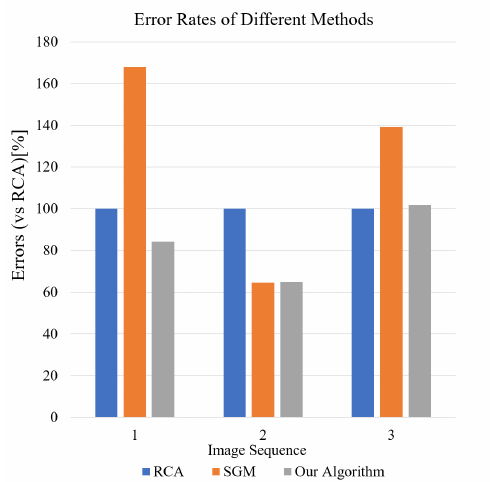
Figure 4 . The statistical results of three stereo matching algorithms’ error rates.